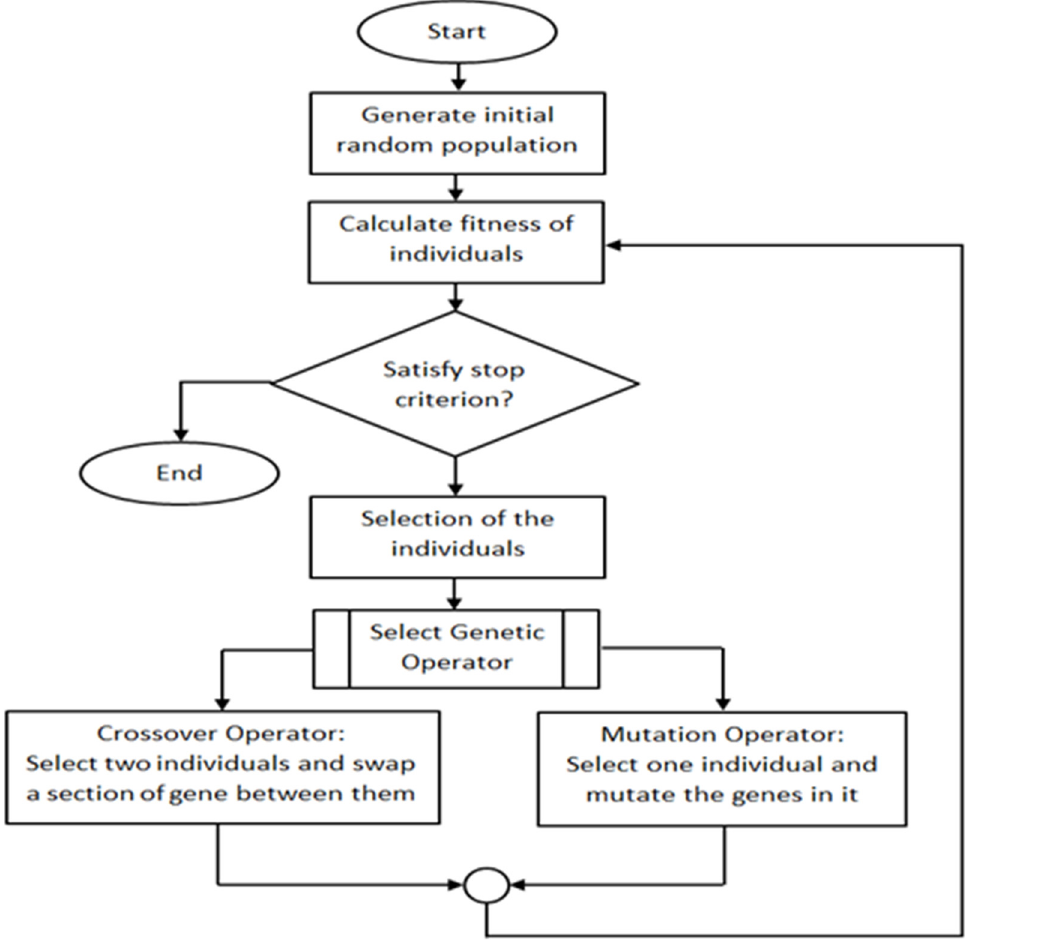
Fig 1. Flow Chart of Genetic Algorithm with all steps involved from beginning until termination conditions met